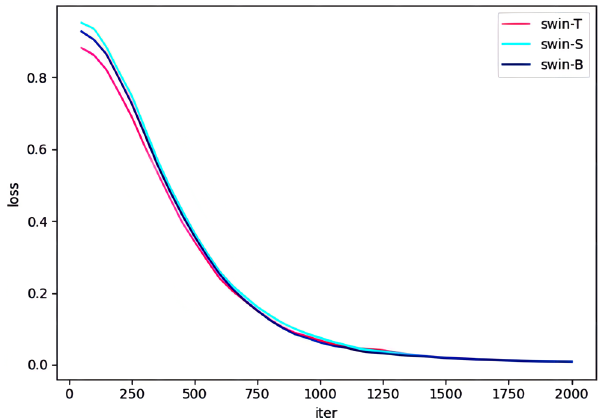
Figure 9. Comparison of loss for different models.